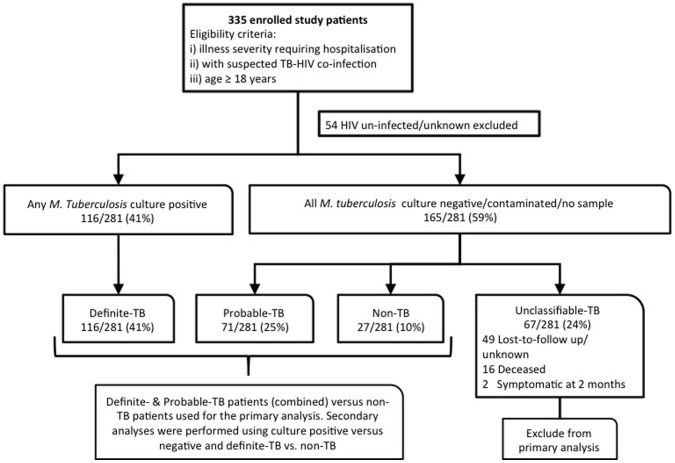
Study population, culture status and diagnostic groups used for analyses.